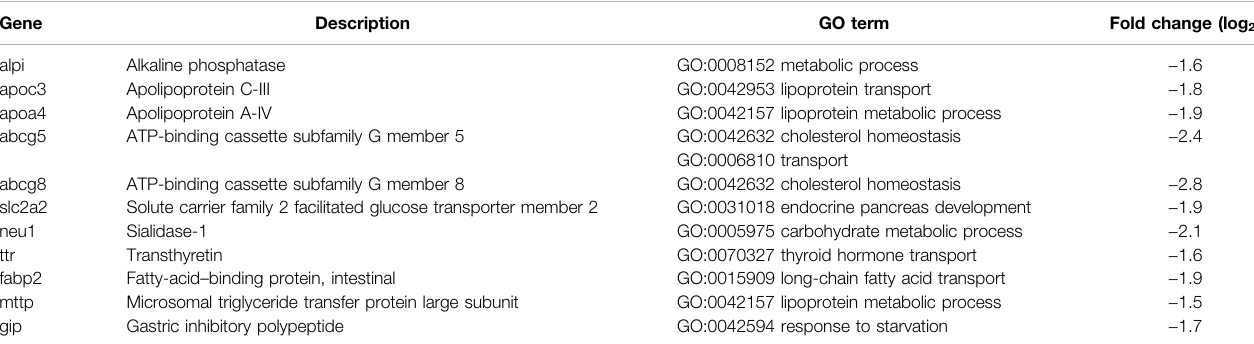
TABLE 2 | Markers of intestinal development in the fetal duodenum between IUTN and IUHS